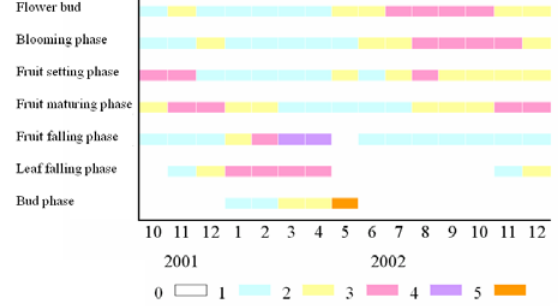
Fig. 2. The phenology of Leucaena leucocephala in study area